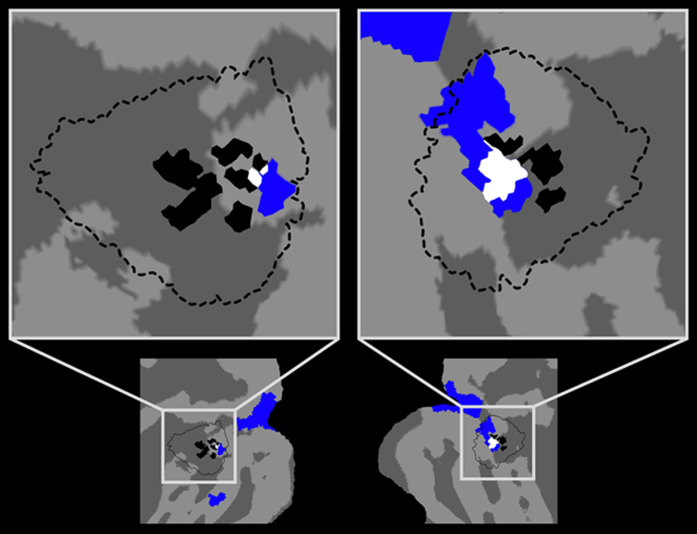
EBA localization.Overlap (white) between the brain activity during mental rotation of full-bodies within the functionally localized EBA (blue) and the peak activity voxels reported in 30 previous studies (black) (Supplementary Table S1). Both the overlap and the activation due to mental rotation of full-bodies were comprised within the regions (dashed line) typically described as EBA (Supplementary Table S1).